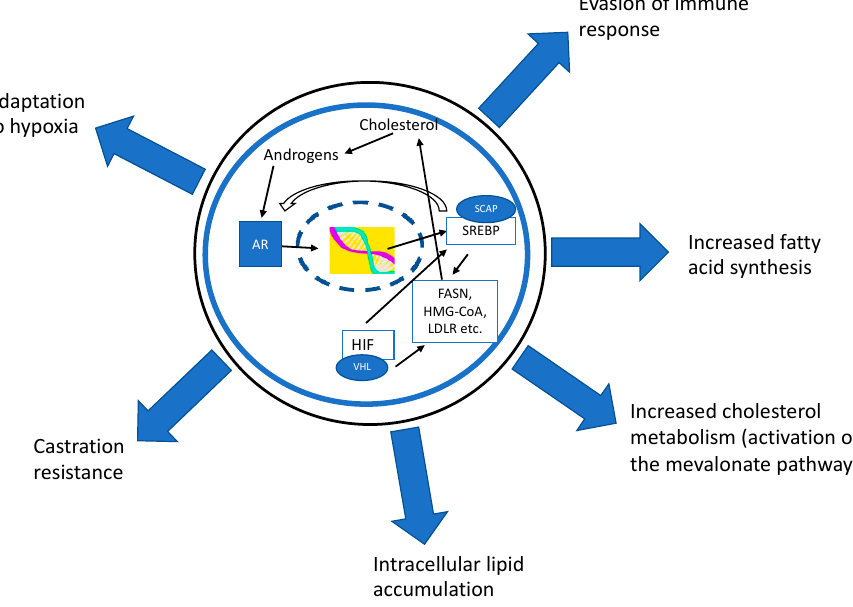
Figure 1. The androgen receptor (AR) modulates the expression of many important genes in the lipid metabolism pathways. Especially sterol regulatory element-binding proteins (SREBP) and fatty acid synthase (FASN) are upregulated in an AR-dependent manner. The AR activates the expression of the SREBP cleavage-activating protein (SCAP) which is needed for SREBP activation. SREBP can induce the activation of FASN, but also upregulates cholesterol metabolism by inducing the mevalonate pathway. SREBP also acts as an oxygen sensor (via hypoxia inducible factor (HIF)) which helps cells to adapt to a hypoxic microenvironment. SREBP increases the expression of AR; thus, the AR–SREBP-axis forms a self-regulating loop ensuring the constant gene expression of transcription factors. The importance of the regulation of lipid metabolism has been demonstrated also in the regulation of tumor-associated immune cells and in development of treatment resistances in prostate cancer.